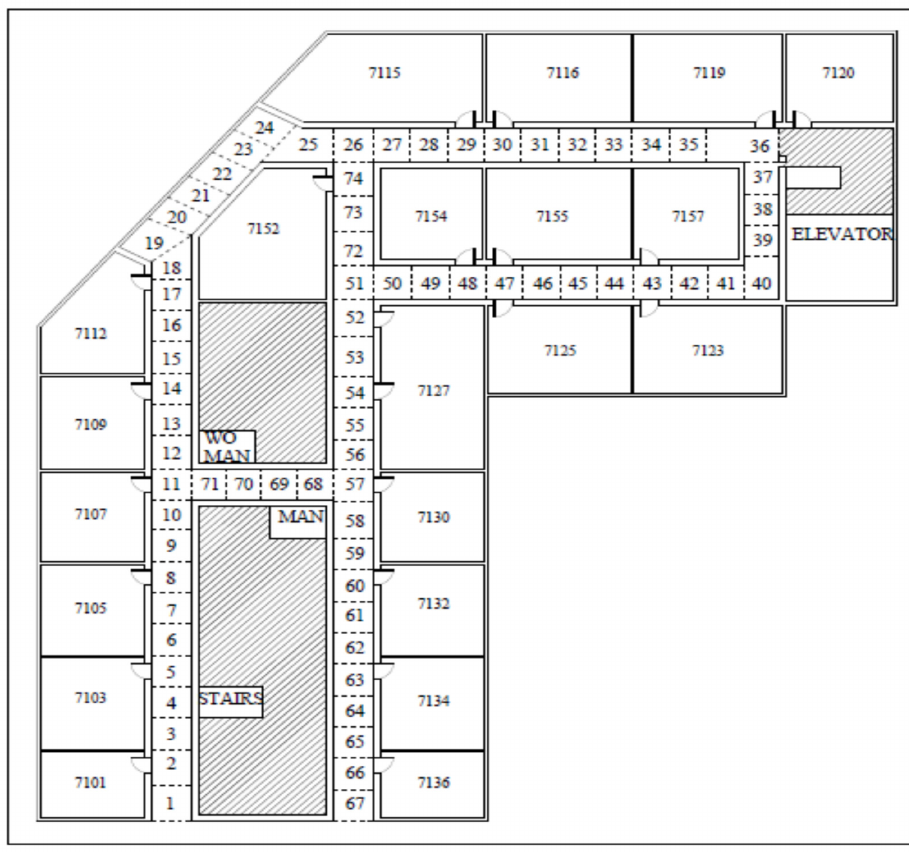
Figure 15. Indoor environment (radio map) for data collection divided into 74 reference points (2 m × 2 m